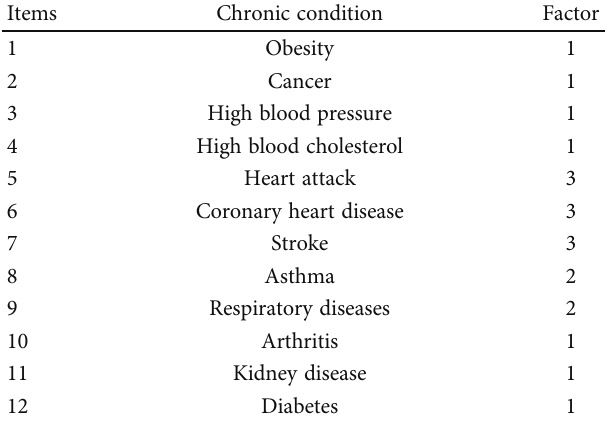
Figure 3: Stability of the 12 chronic conditions of the EGA. Note: in the EGA, the nodes correspond to each instance of the item (comorbidity) in the initial dimension identi fi ed by the analysis. (1) Obesity, (2) cancer, (3) high blood pressure, (4) high blood cholesterol, (5) heart attack, (6) coronary heart disease, (7) stroke, (8) asthma, (9) respiratory diseases, (10) arthritis, (11) kidney disease, and (12)